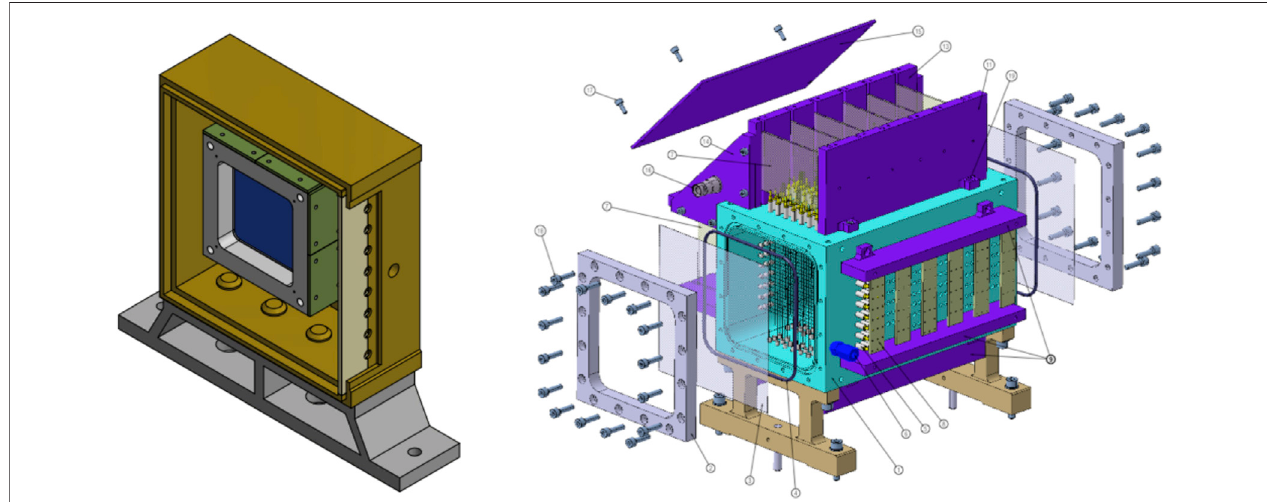
FIGURE 2 | Left: Start Counter detector inside the plastic box. The aluminum mechanical structure holds the EJ-228 plastic scintillator foil (in dark blue). Right: Technical drawing of the Beam Monitor drift chamber. The two orthogonal views x – y of the wires are clearly visible. Two enclosing mylar windows held by aluminum frames are shown as